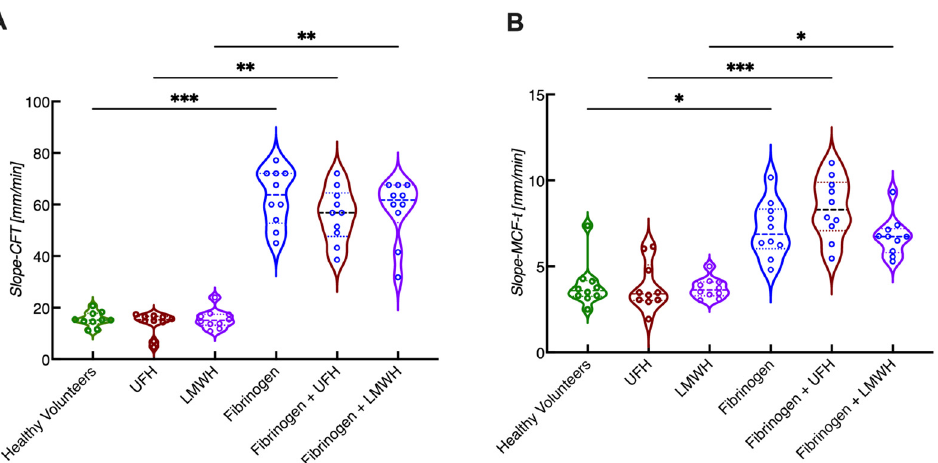
Figure 5. Comparison of new ROTEM parameters slope-CFT and slope-MCF-t derived from in vitro spiking experiments. Whole blood samples were obtained from healthy volunteers and spiked with anticoagulants (unfractionated heparin, UFH or low molecular weight heparin, LMWH) and/or fibrinogen. (See experimental details in [50]). Slope-CFT ( A ) and slope-MCF-t ( B ) are shown. n = 10, * p < 0.05, ** p < 0.01, *** p < 0.001.